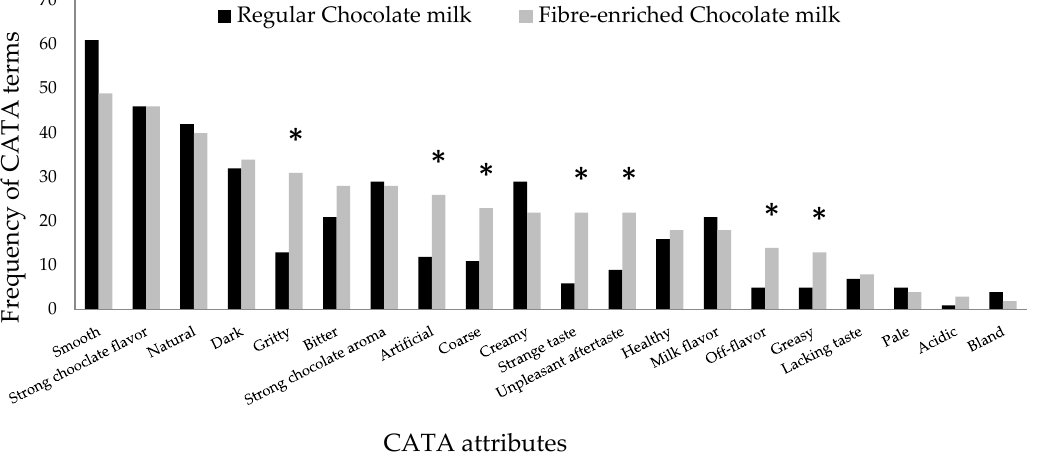
Figure 3. Frequency of CATA terms for fibre-enriched chocolate milk and regular chocolate milk. * indicates significant difference at p < 0.05.